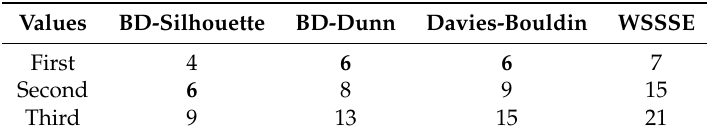
Table 1. Majority voting methodology.